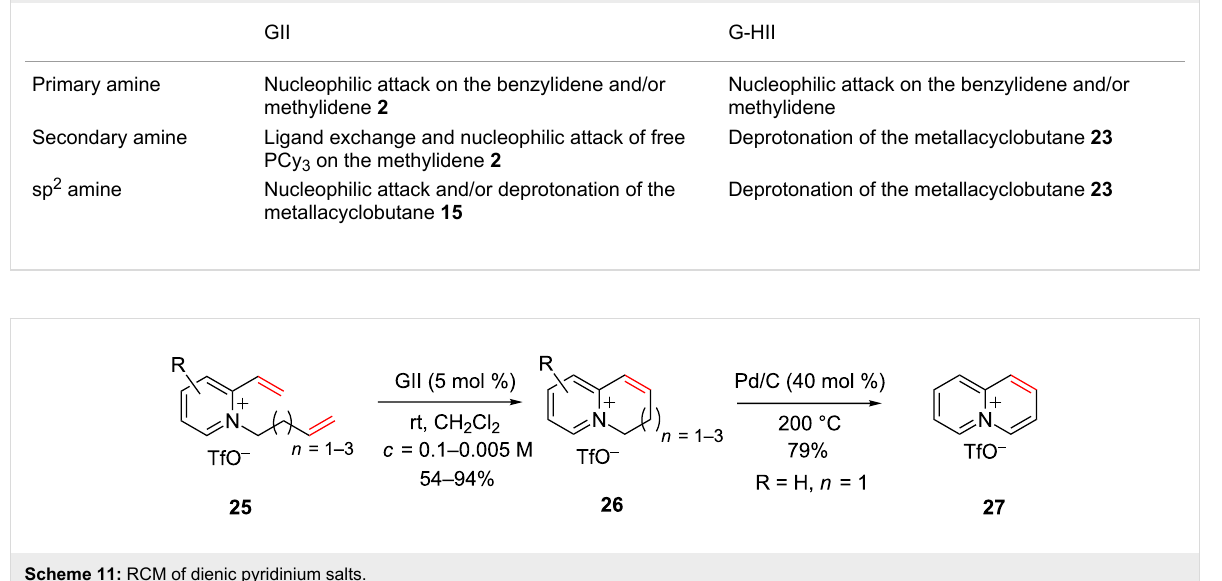
Table 3: Amine-induced degradation pathways of GII and G-HII. GII